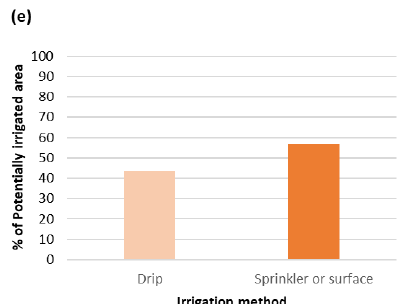
Figure 10. Percentages of Moderate Risk of Sodification areas per slope class ( a ), drainage class ( b ), soil reference group ( c ), land occupation ( d ) and irrigation method ( e ). LP—Leptosols; LV—Luvisols;